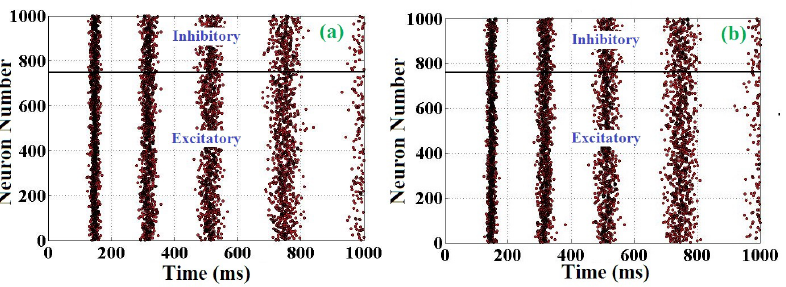
Figure 6. Raster plot shows the 2000 connected ADEX neurons. ( a ) Original model. ( b ) Pro- posed model.